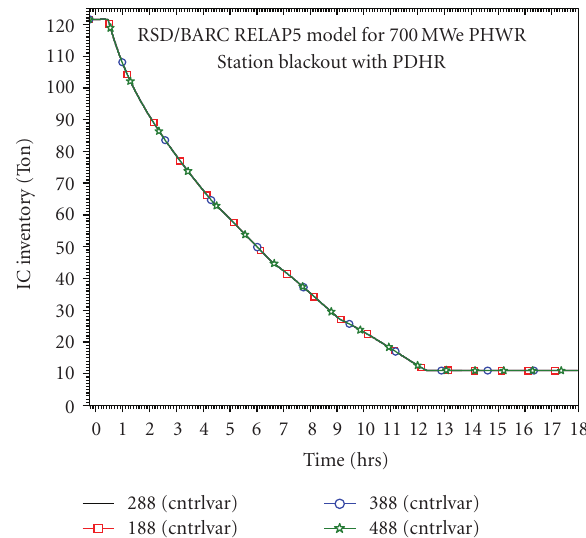
Figure 16: PDHR shell inventory variation case-no delay in valving in PDHRS.